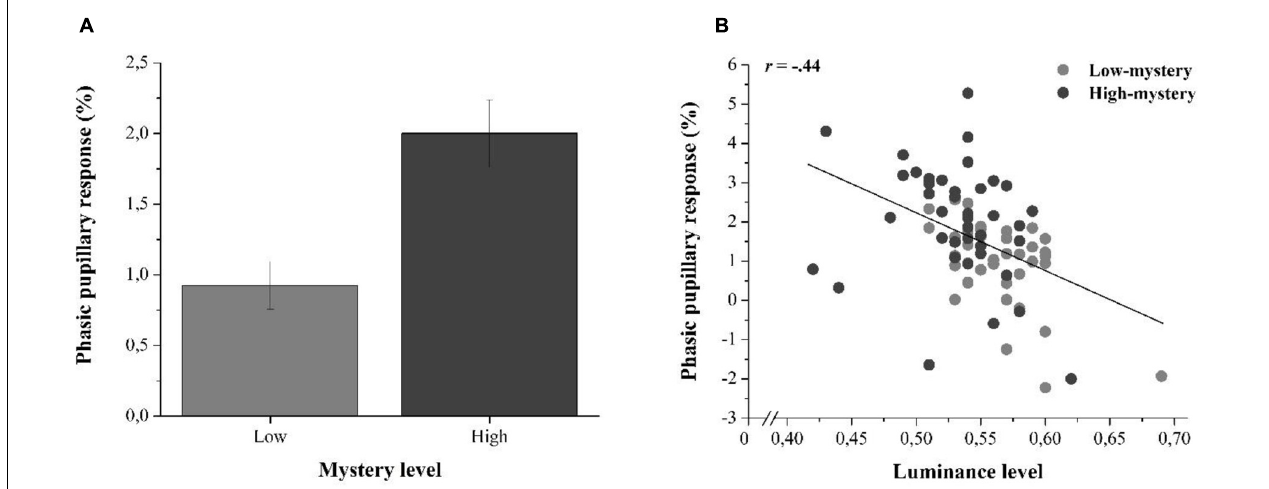
FIGURE 3 | (A) Averaged phasic pupillary responses (in %) elicited by the nature images presented in low- and high-mystery trials. Error bars represent the standard error of the mean. (B) Scatter plot illustrating the relationship between the luminance level and the phasic pupillary response (in %) as a function of the type of trial.